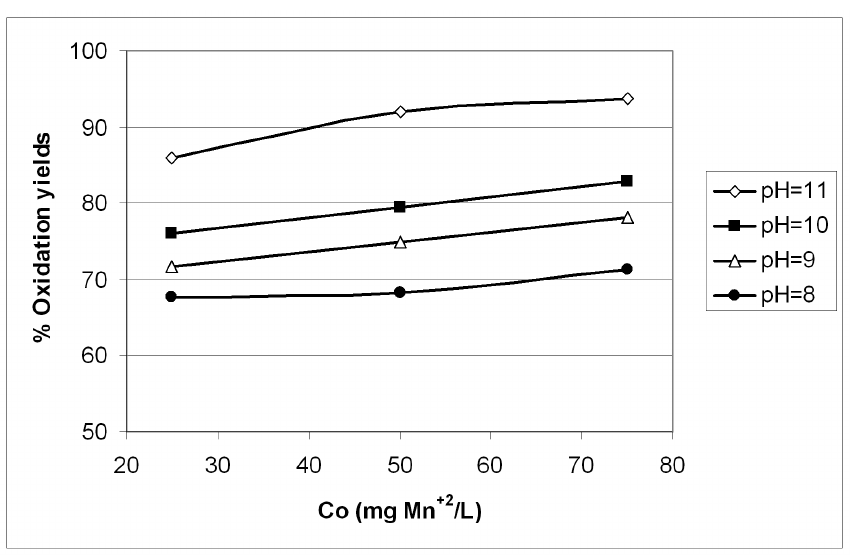
Fig. 2 Oxidation yields as a function of pH and concentration (20 ◦ C, solution with glass bead).